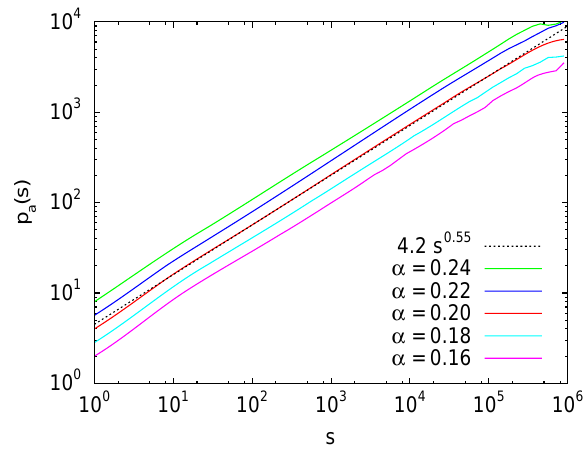
Fig. 2. Scaling behavior of the accessible perimeter of events in the OFC model numerically determined for different values of α on a 1024 × 1024 lattice. The curves referring to α 6= 0 . 20 were shifted vertically for